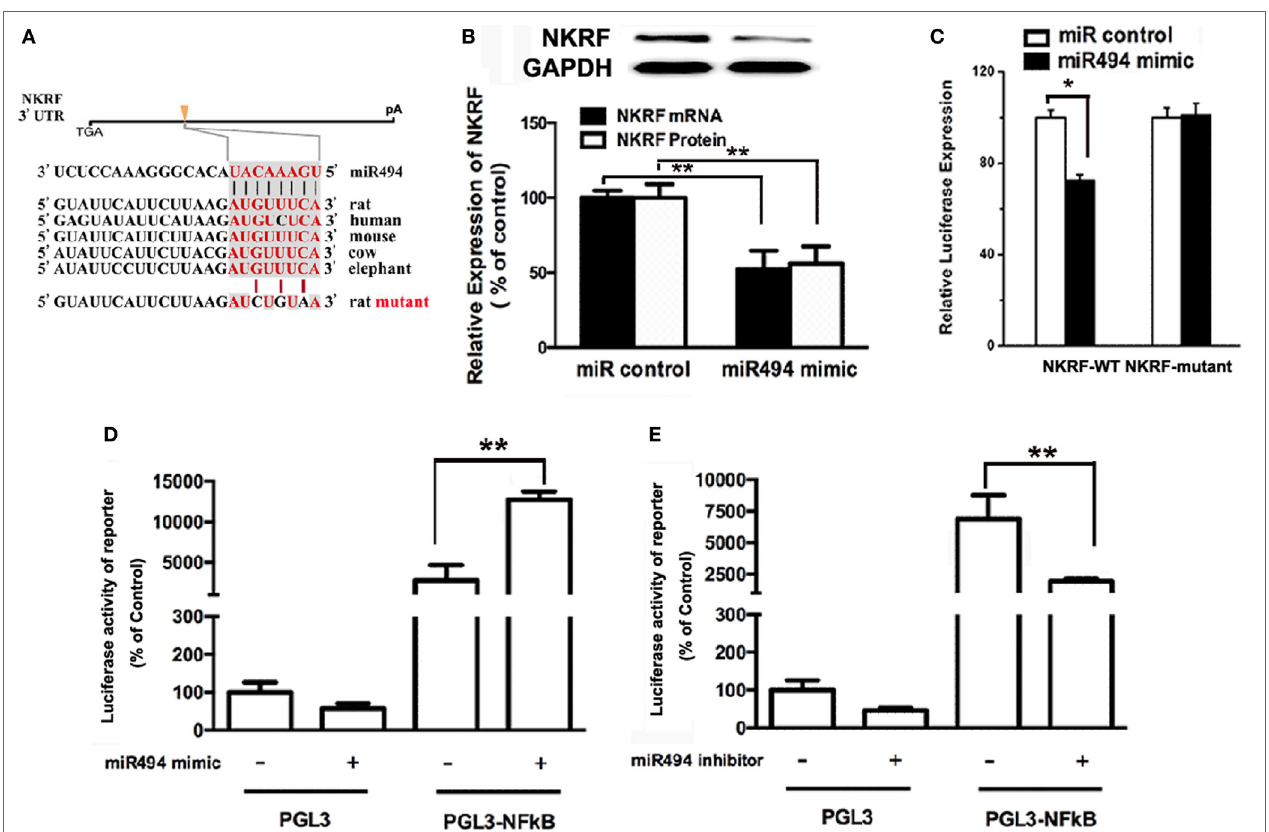
FigUre 4 | miR-494 targets NF- κ B repressing factor (NKRF), thus activating NF- κ B. (a) NKRF contained highly conserved miR-494-mRNA interaction motifs within their 3 ′ untranslated regions (UTRs), and the sequences of the wild-type (WT) and mutant 3 ′ UTR of NKRF for the luciferase reporter assay are shown. (B) H9c2 were transfected with microRNA (miR) control or miR-494 mimics (200 nM) for 24 h. Quantitative real-time RT-PCR and western blot analysis were used to determine the NKRF mRNA and protein expression in cardiomyocytes, respectively. (c) H9c2 co-transfected with 0.4 µg of WT or mutant NKRF 3 ′ UTR reporter plasmids in the presence of miR control or miR-494 mimics (200 nM). 24 h later, luciferase activity was measured using dual-luciferase assay. (D) H9c2 co- transfected with 0.4 µg of pGL3 or pGL3-NF κ B reporter plasmids in the presence of miR control or miR-494 mimic (200 nM). 24 h later, luciferase activity was measured using dual-luciferase assay. (e) H9c2 co-transfected with 0.4ug pGL3 or pGL3-NF κ B reporter plasmids in the presence of miR control or miR-494 inhibitor (200 nM). 24 h later, luciferase activity was measured using dual-luciferase assay. All bar graphs represent the mean ± SEM from four independent experiments. * P < 0.05, ** P <